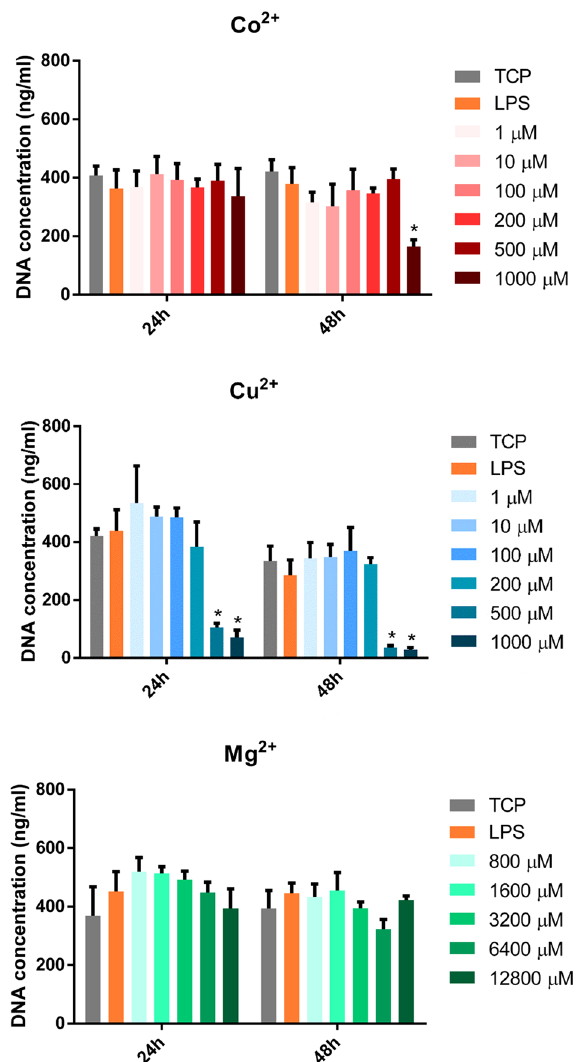
Figure 2. Effect of Co 2+ , Cu 2+ and Mg 2+ ions on THP-1 cell proliferation. DNA quantification of THP-1 cells cultured with different Co 2+ , Cu 2+ and Mg 2+ concentrations for 24 and 48 h. The results of DNA quantification were compared to the TCP of each day and a statistically significant ( p < 0.05) decrease was observed in some concentrations of Co 2+ and Cu 2+ . Statistically significant differences ( p < 0.05) were represented with *.